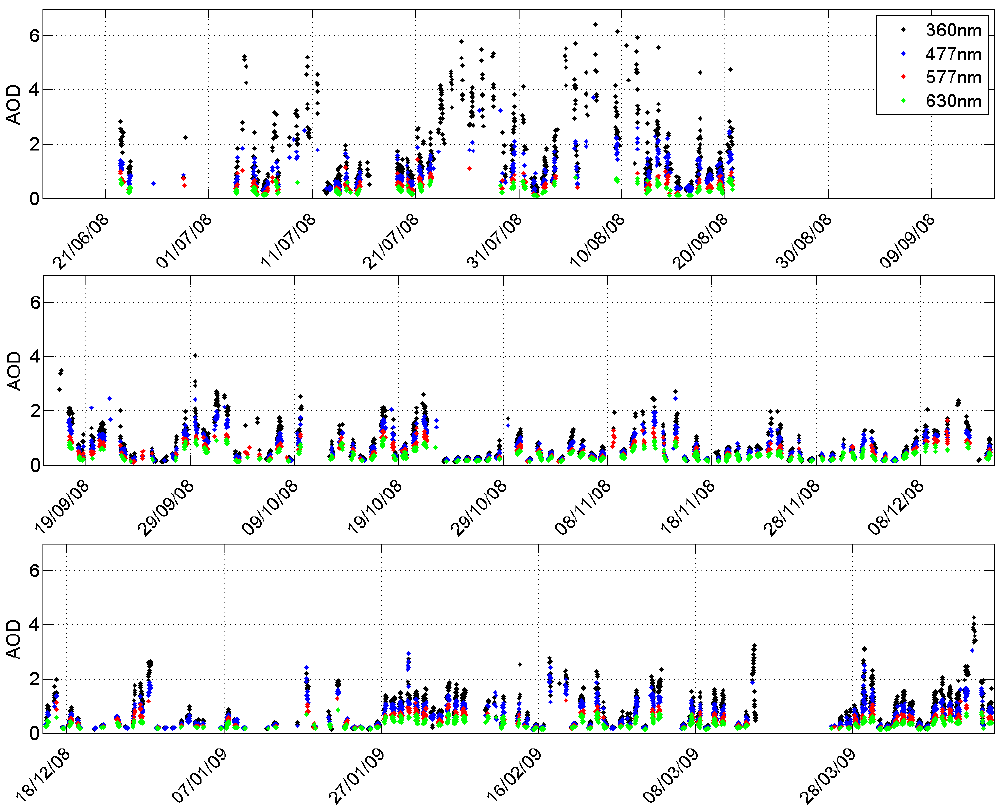
Fig. 8. Time series of the tropospheric total AODs at 360, 477, 577, and 630nm retrieved from MAXDOAS measurements made in Beijing from June 2008 to April